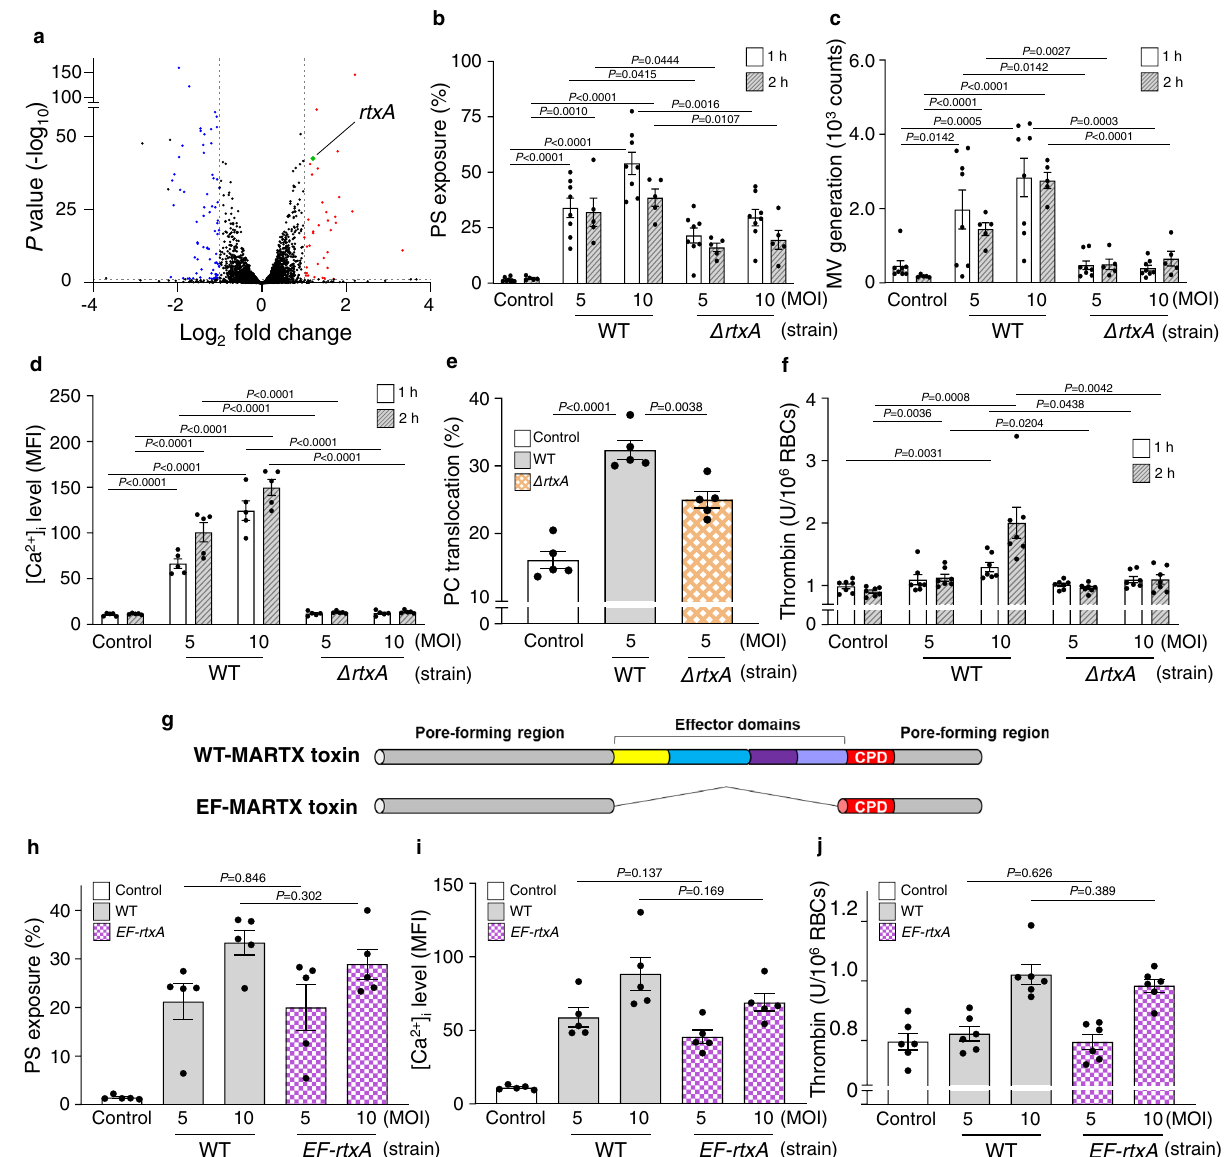
Fig. 3 | The V. vulni fi cus MARTX toxin is responsible for the procoagulant and prothrombotic activity of human RBCs. a A volcano plot representing differ- entially expressed genes in V. vulni fi cus exposed to RBCs. The genes signi fi cantly upregulated or downregulated (|log 2 fold change| ≥ 1.0, and P value ≤ 0.05) are shown in red or blue dots, respectively. A rtxA gene is indicated by a green dot. b – f RBCs were infected with either V. vulni fi cus WT or Δ rtxA at various MOIs